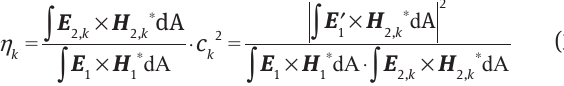
, for example, the HE 1 11 ′ ); output guided modes 1 ). Non-coupled radiation modes ( E ) are not β 2, k